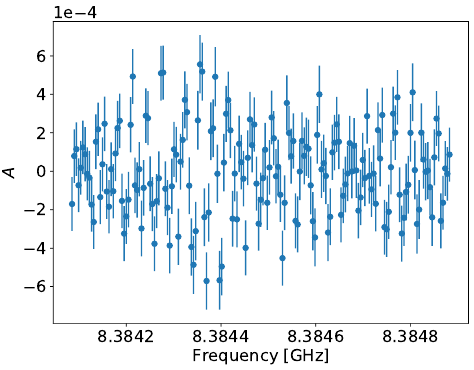
Figure 7 . Amplitude A (in units of normalized power excess) of the axion signal provided by the fit for each of the probed axion frequencies.